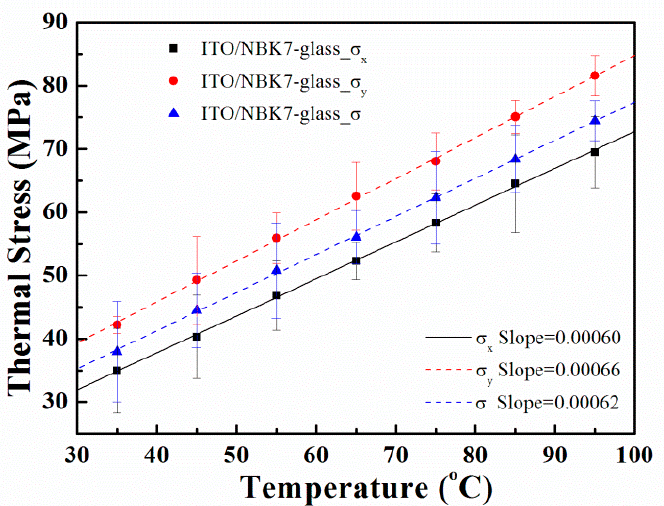
Figure 6. Thermal stress vs. temperature plot of ITO coated on the N-BK7 substrate.